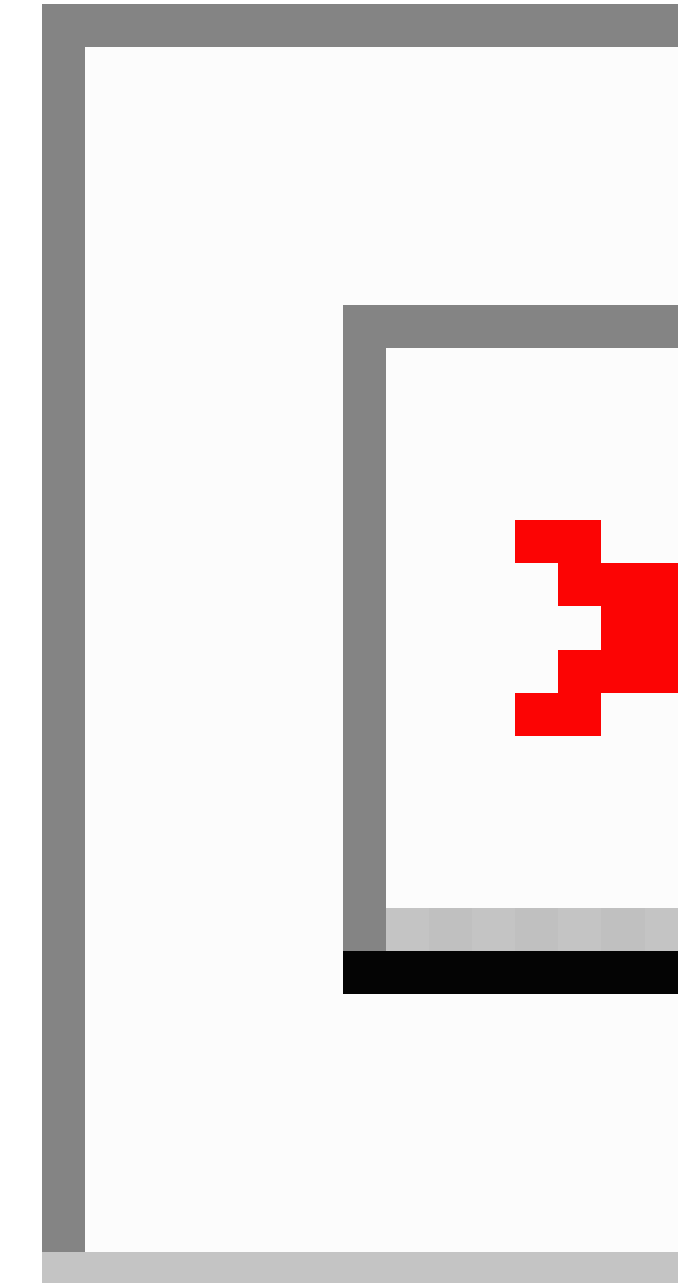
Figure 1. The metadata filling interface in meducator